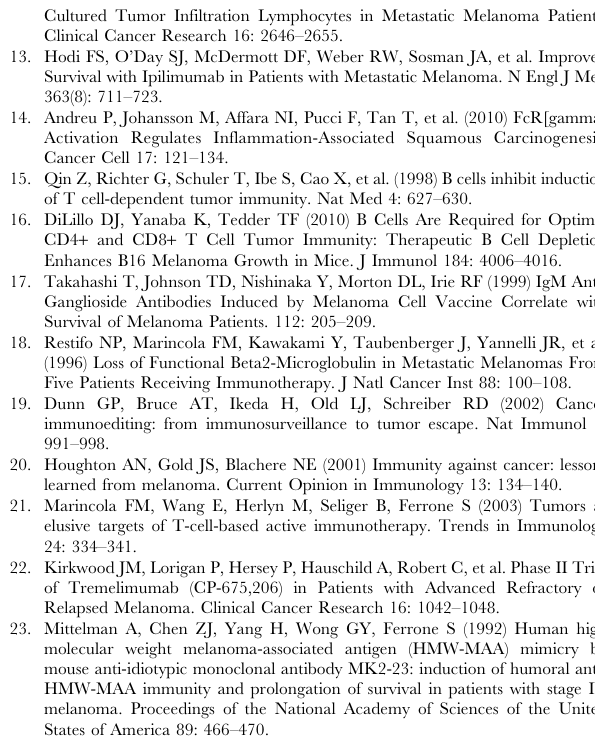
Figure S1 Schematic of cell-based ELISA used to detect antibodies against tumor cell antigens. Figure S2 Secretion of IgG antibodies from peripheral blood B cells derived from patients and healthy